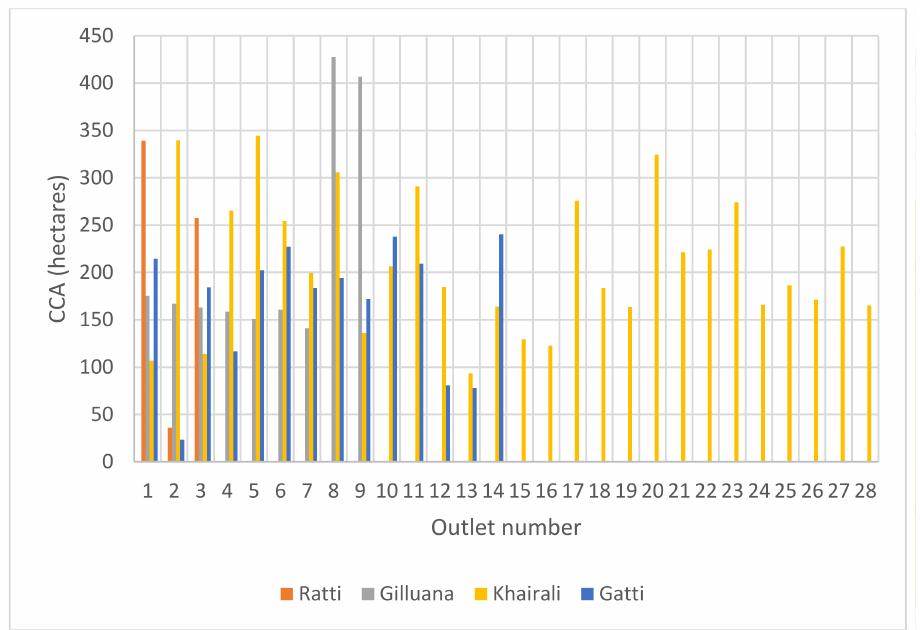
Figure 8. CCA of each outlet in the selected